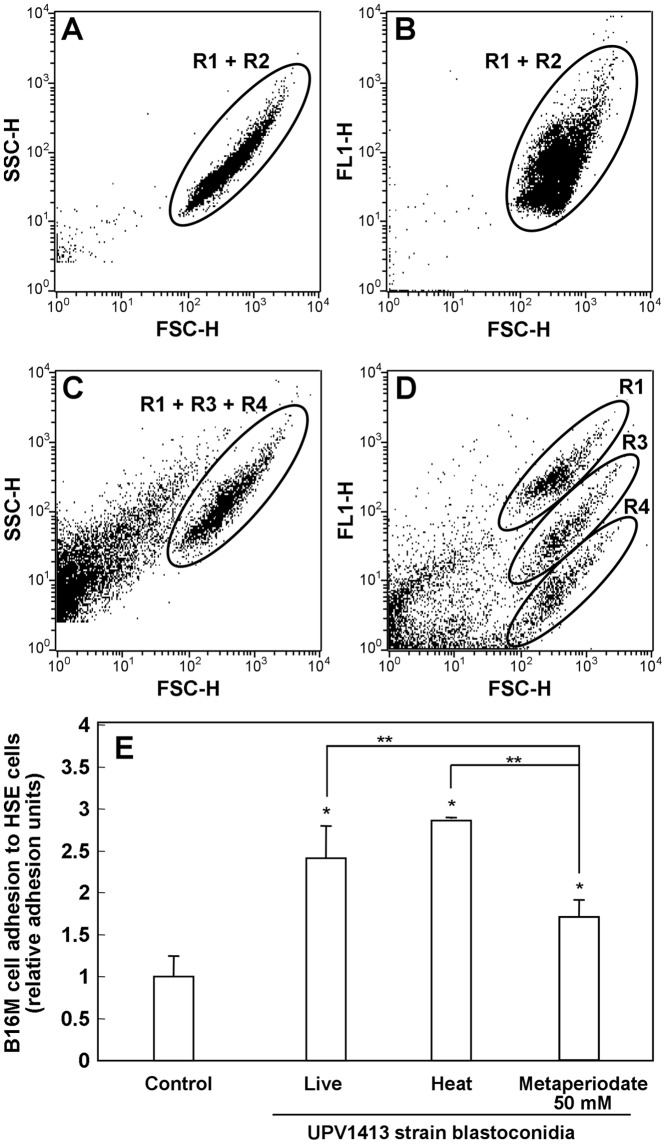
Results obtained from the killing treatments.(A–D) Effect of heat and metaperiodate treatments on Candida albicans cell surface studied by incubation with Con A-FITC followed by flow cytometry: cell complexity (side scatter, SSC), cell size (Forward Scatter, FSC), and fluorescence (FL1). R1: live cells. R2: cells killed with heat. R3: cells killed with a 20 mM metaperiodate. R4: cells killed with 50 mM metaperiodate. (E) Effect of heat- and sodium metaperiodate (50 mM)-treated C. albicans blastoconidia on the increase of B16 melanoma (B16M) cell adhesion to HSE. The results shown correspond to the mean ± SD of three independent experiments. Statistically significant differences with respect to the control or between cell conditions are indicated by one and two asterisks (**) (p<0.05), respectively.